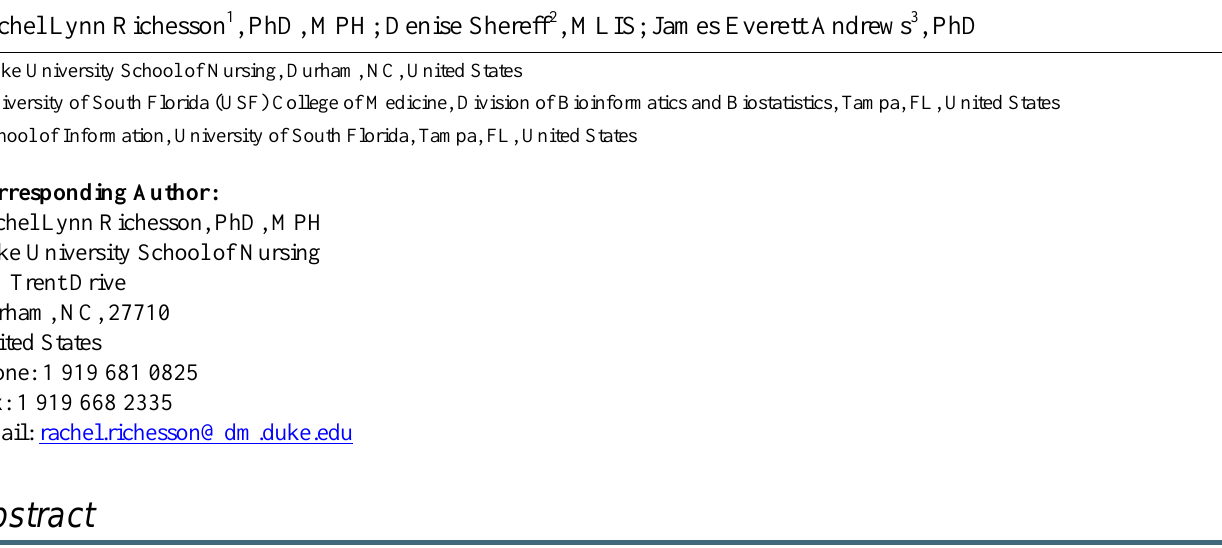
Patient registries; data standards; rare diseases;